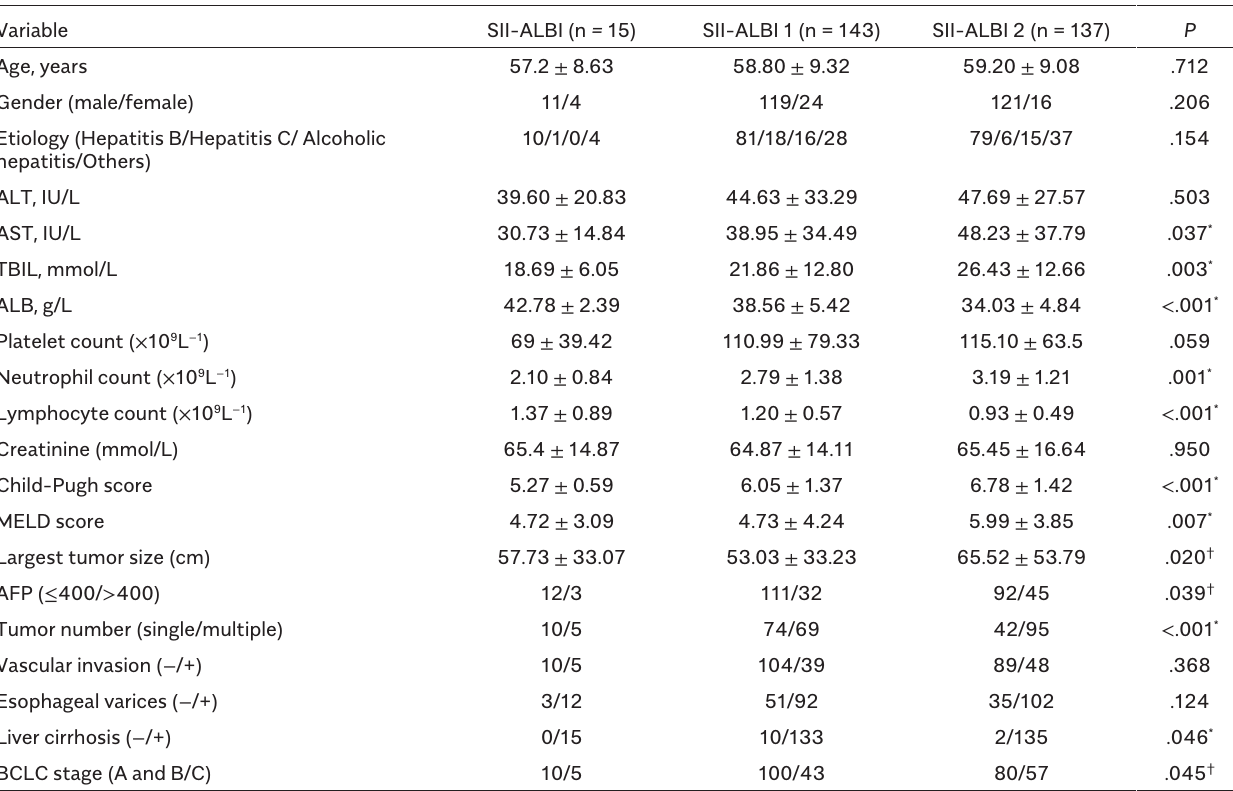
Table 2. Comparison of the Clinical Characteristics of Patients with Different SII-ALBI Scores